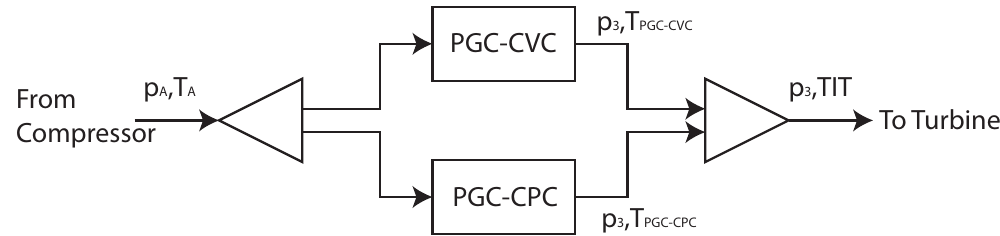
Figure 3. Schematic of the two component of the PGC combustor and their connections to the upstream and downstream components of the